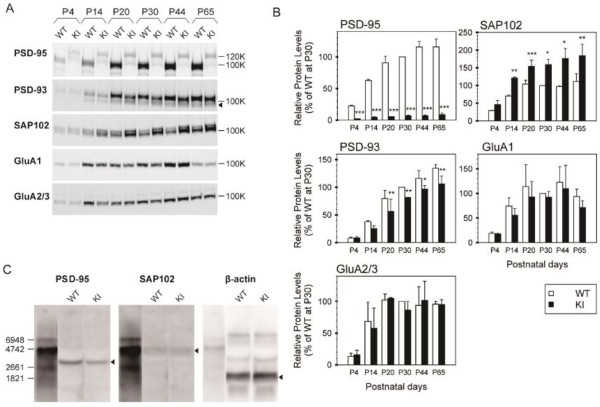
Altered expression of SAP102 and PSD-93 in the hippocampus of KI mice. A, Immunoblot analyses of hippocampal homogenates from WT and KI mice at the respective developmental ages for the indicated proteins. The following amounts of homogenate proteins were analyzed per lane: PSD-93 and SAP102, WT and KI: 5 μg; GluA1 and GluA2/3, WT and KI: 10 μg; and PSD-95, WT: 5 μg, KI: 20 μg. The arrowhead indicates the degraded bands of PSD-93. B, Quantitation of PSD proteins in the hippocampal homogenates based on the results shown in A, normalized to the wild-type levels at P30 (set as 100%). The histograms show the mean ± SEM (open bars, WT; filled bars, KI). Three sets of hippocampal homogenates at various ages (P4–P65) were examined. The means and SEM of WT and KI data were compared using Student’s t-test. *P < 0.05, **P < 0.005, ***P < 0.001. In the KI PSD homogenates, extensively low levels of mutant PSD-95, significantly decreased levels of PSD-93, and increased levels of SAP102 were observed during development compared to the WT mice, while the levels of GluA1 and GluA2/3 were not significantly different from those of the WT mice. C, Northern blot analyses of PSD-95 and SAP102 mRNA. Ten micrograms of total RNA prepared from WT and KI mice hippocampi were analyzed in a formaldehyde-containing 1% agarose gel. The numbers on the left side indicate the sizes of the digoxigenin-labeled RNA molecular weight markers. Arrowheads indicate the major band for each mRNA.